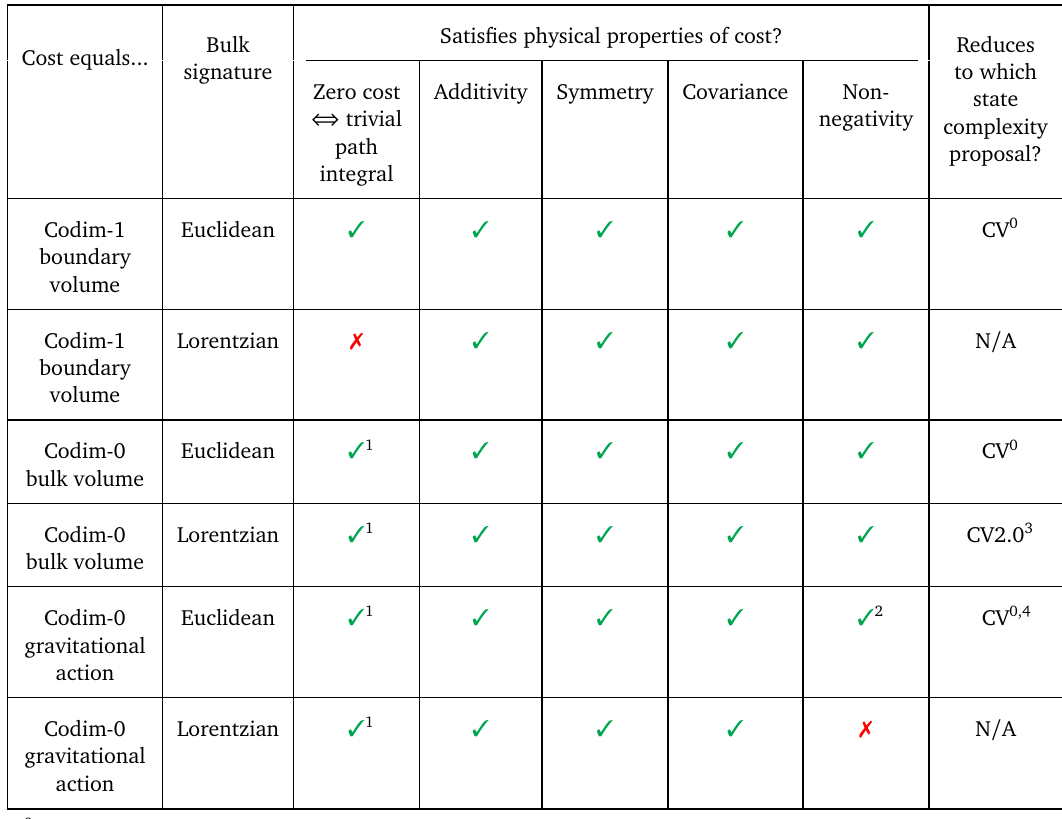
to which state complexity